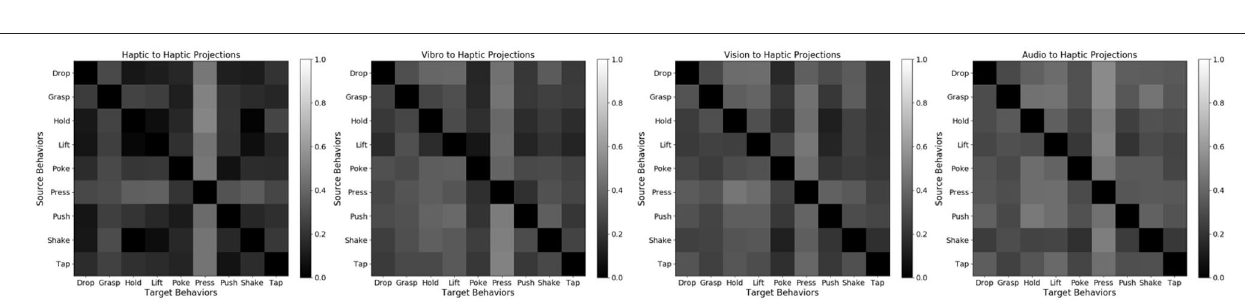
FIGURE 18 | Accuracy Delta for 4 mappings using β -VED: haptic to haptic , vibro to haptic , vision to haptic , audio to haptic . Darker color means lower Accuracy Delta (better) and lighter color means higher Accuracy Delta